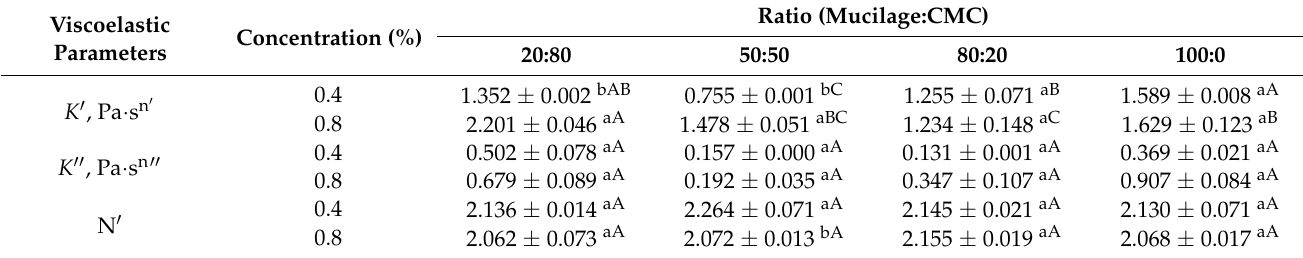
Table 4. Viscoelastic parameters estimated according to power law model, in soft serve ice